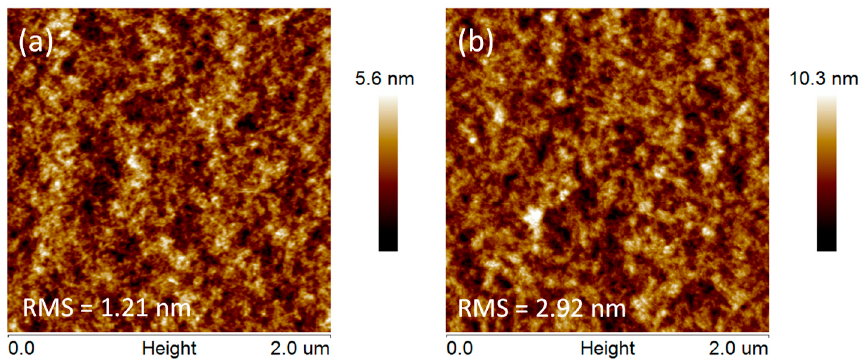
Figure 3. Atomic force microscopy (AFM) images of PEDOT:PSS films ( a ) without and ( b ) with DMSO solvent washing treatment.